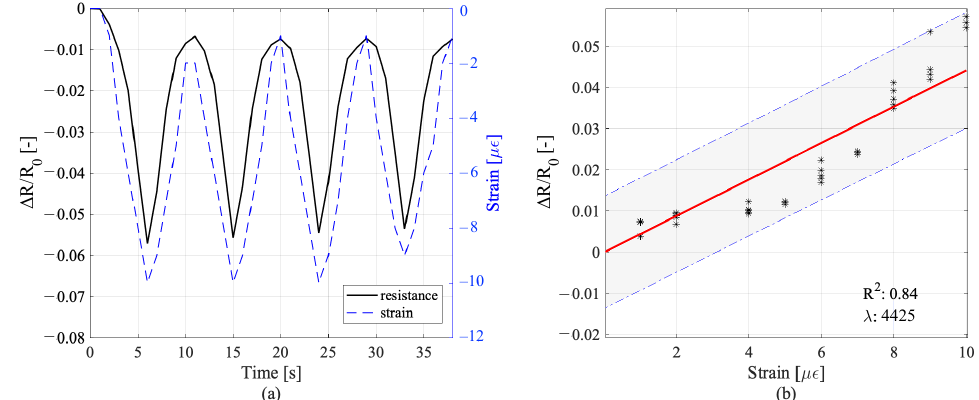
Figure 10. Sensitivity response of the plate sample under the cyclic surface loads: ( a ) variation of resistance and the measured strain time histories; ( b ) resistance variation versus strain, and linear model of